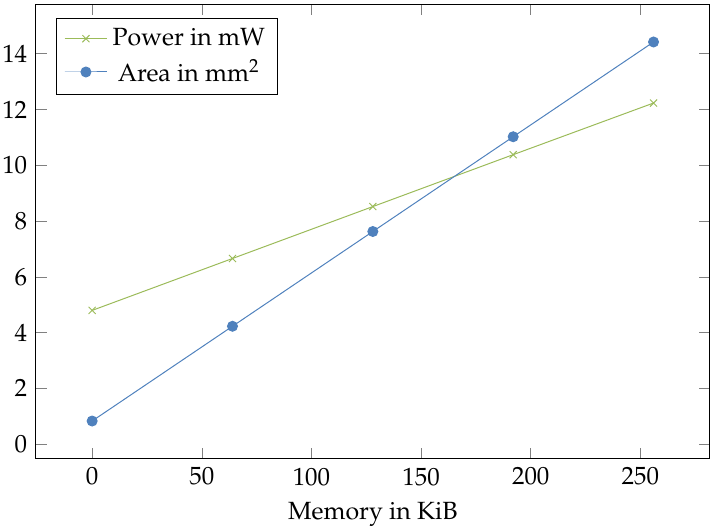
Figure 10. Impact of memory installed with an AIRISC microprocessor to power consumption and silicon area